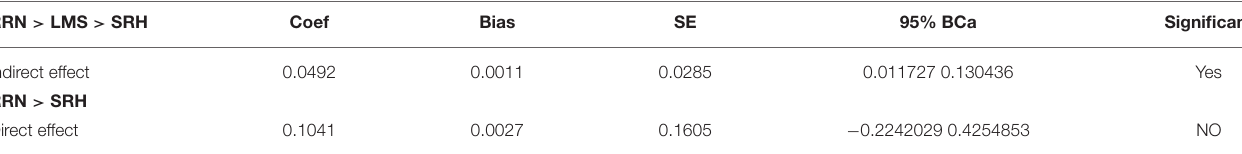
TABLE 4 | Build BCa and test mediation hypotheses using the bootstrap